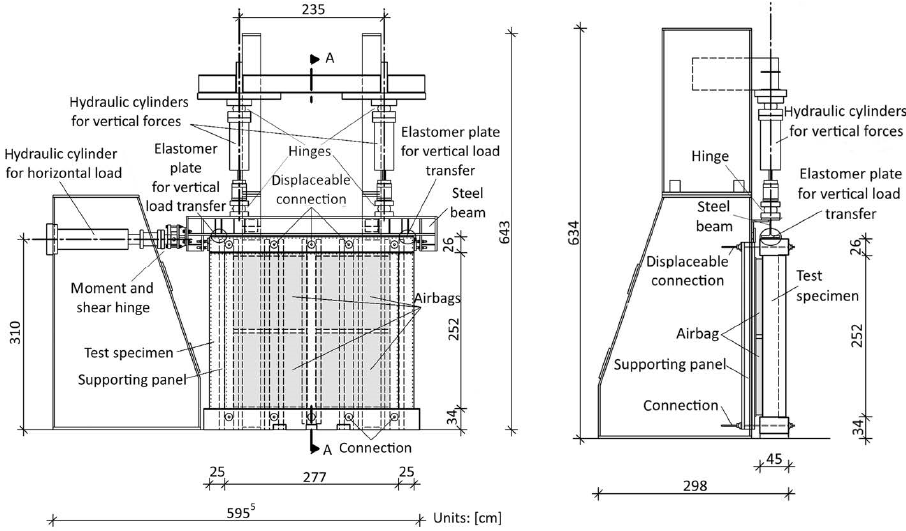
Figure 6. Test setup for the in-plane and out-of-plane tests carried out by Butenweg et al. [16].